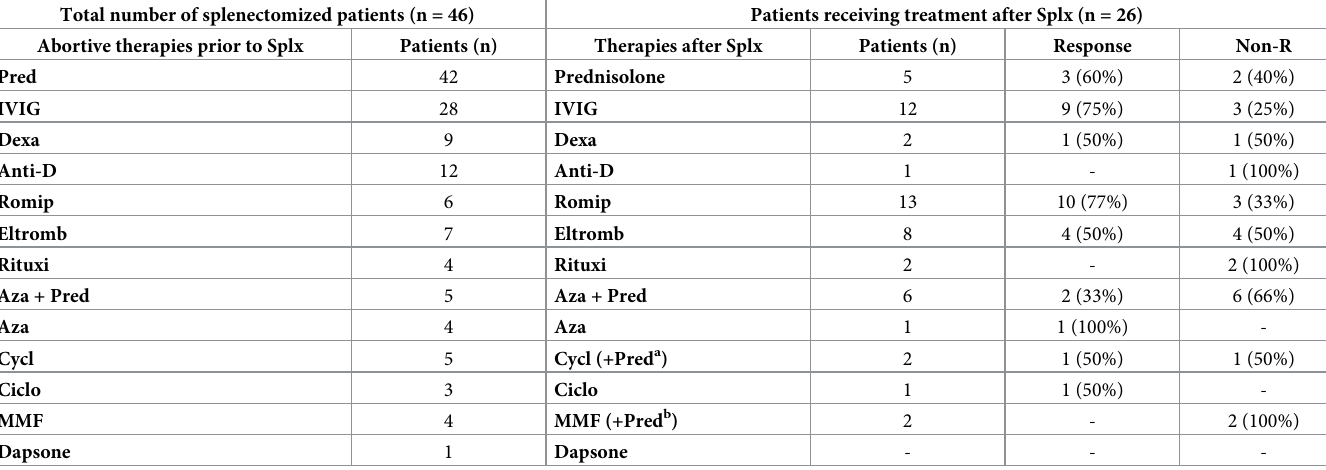
Response = short-course treatments: elevation of platelets (cid:21) 30 x10 9 /L and at least doubling of the baseline value within their known agent specific time to peak response [32]. Continuous treatments: sustained platelet counts (cid:21) 30 x10 9 /L with at least doubling the baseline value and absence of bleeding during observation. Non-R = non-responder (patients that did not show elevation of platelets (cid:21) 30 x10 9 /L and at least doubling of the baseline